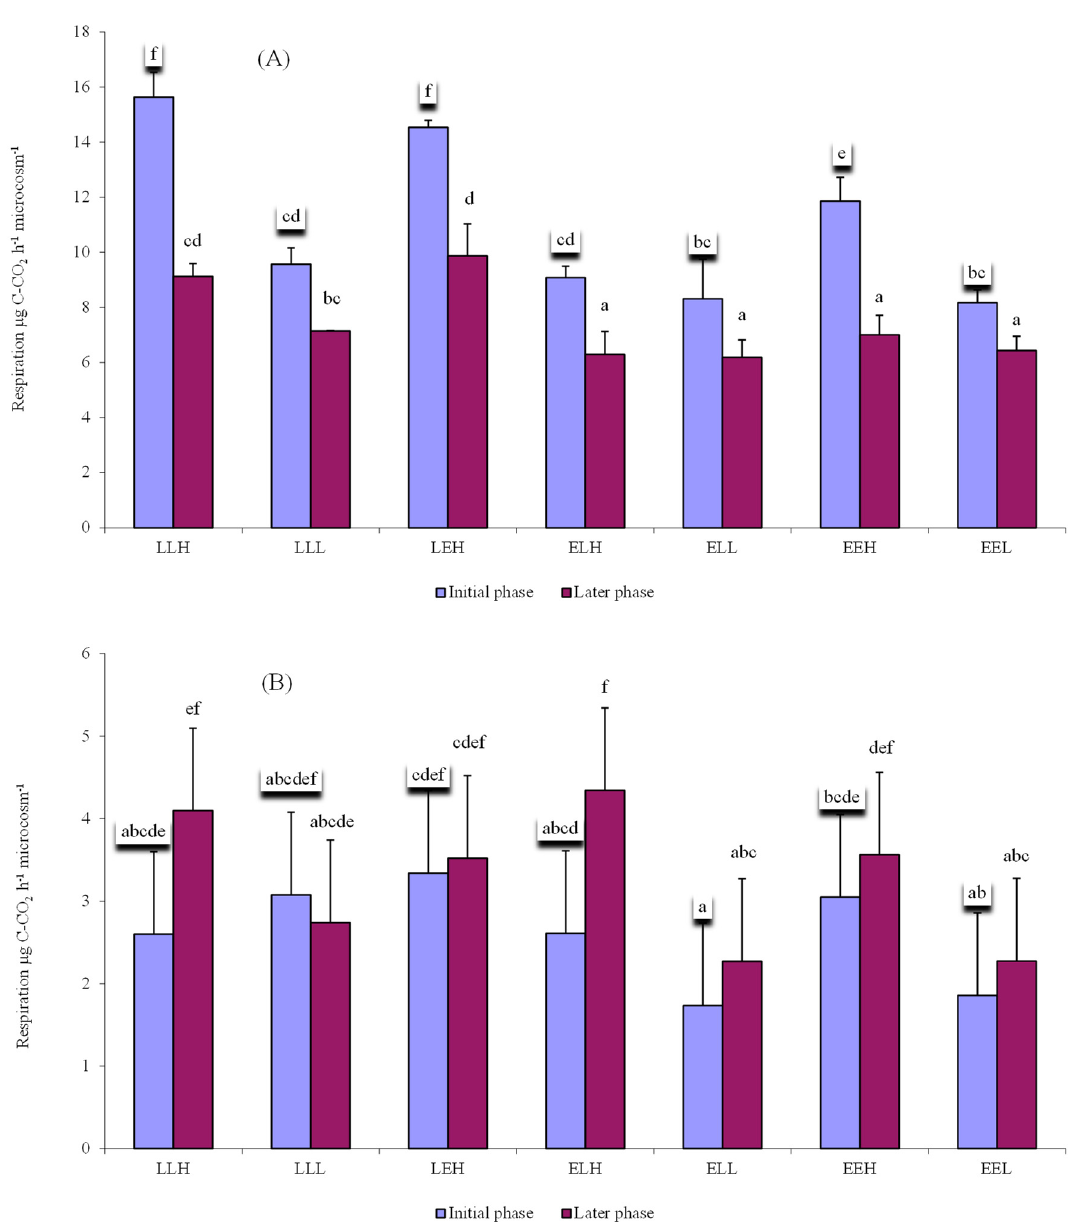
Figure 2. Average respiration ( µ g C-CO 2 h − 1 microcosm − 1 ) of individual treatments with the addition of litter ( A ) or without the addition of litter ( B ) in the first 51 days (initial phase) and the subsequent 83 days (later phase). Error bars are standard deviation. Results are based on repeated measurement ANOVA. If ANOVA for the soil type was significant, the results of the post hoc test (Fischer LSD, p < 0.05) are given. Homogeneous statistical groups are shown by the same letters. A significantly higher ergosterol content was evident in the treatments of late soil (Figure 6). The ergosterol content was highest in the LLL-Cal sample with the addition of litter (0.87 ppm). For samples without the addition of litter, the highest value